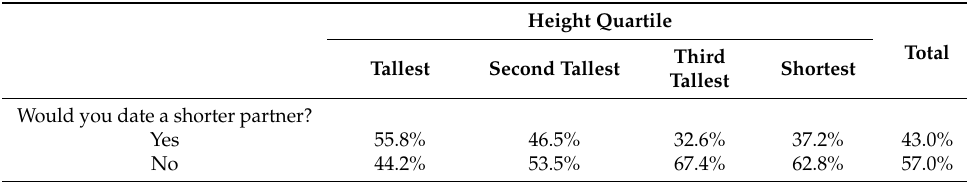
Table 2. Cross-tabulations of whether or not participants would date a shorter romantic partner across height quartiles.